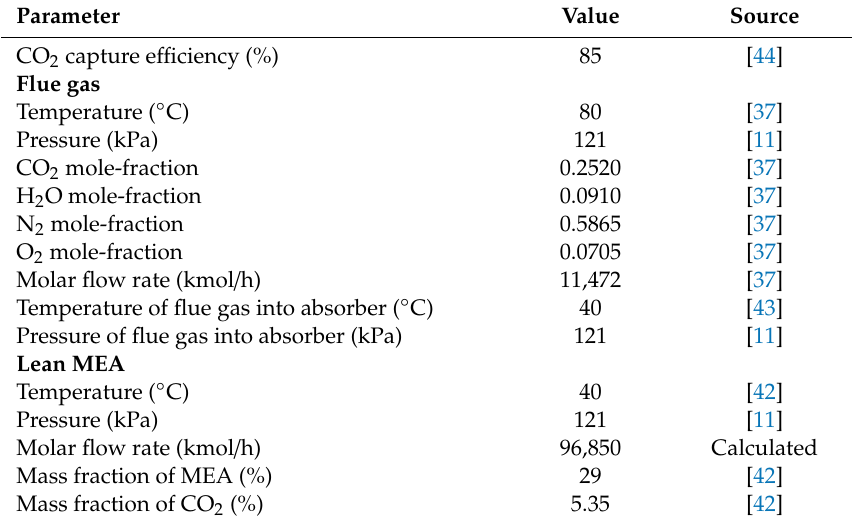
Table 1. Specifications and assumptions for